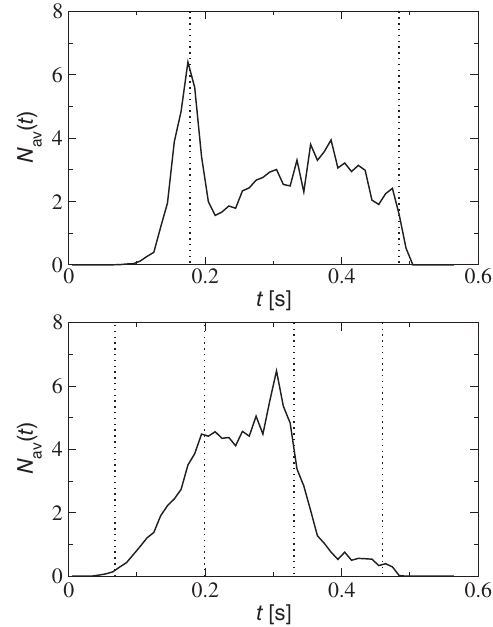
FIG. 7. Spills of the extraction of Ar 18 þ beams at beam energy E ¼ 500 MeV = u bunched with rf fields of the harmonic number h ¼ 100 obtained by particle tracking. Upper graph: The rf ¼ 70 kV is applied and the horizontal tune is moved voltage V rf ¼ 4 . 326 to Q ¼ 4 . 334 . Lower graph: The rf voltage from Q x; x; f i V ¼ 5 kV is applied and the horizontal tune is moved from rf Q ¼ 4 . 329 to Q ¼ 4 . 334 . The dotted lines mark the crossed x; i x; f synchrobetatron resonances.